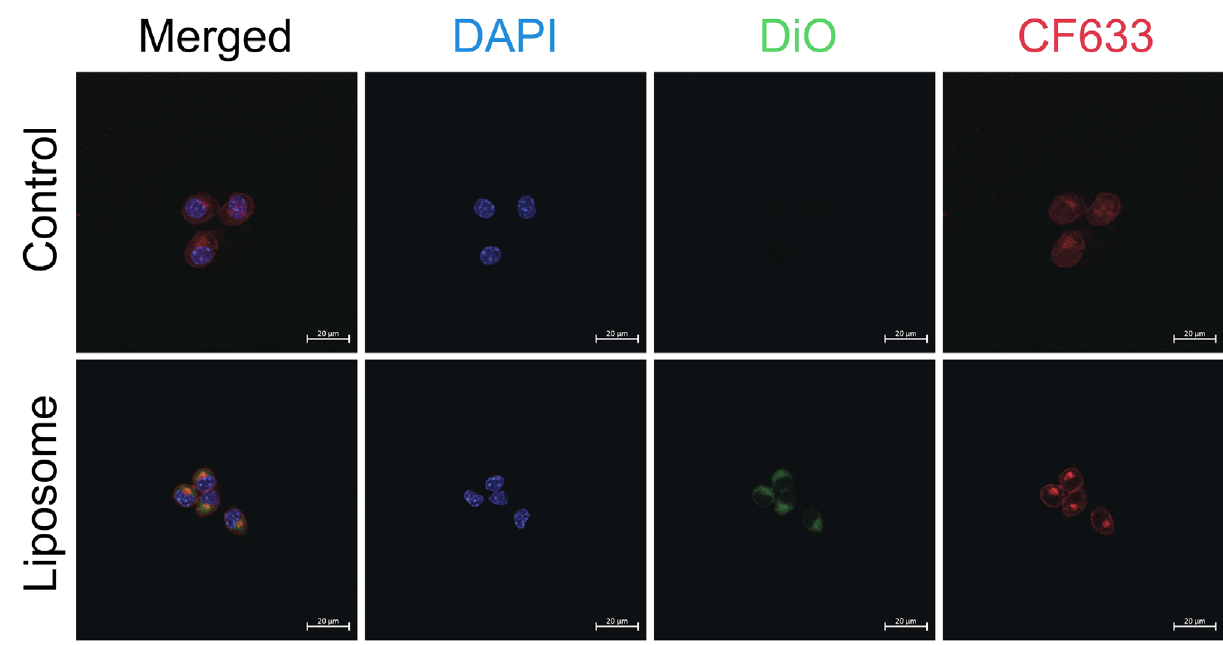
Figure 3. RAW 264.7 macrophages were incubated with DiO-liposomes (green) for 4 h before being washed, fixed, permeabilized, and stained with DAPI (blue) for nuclei visualization and phalloidin CF6333 (red) for F-actin visualization. There is a visible DiO signal inside cells that were treated with DiO-liposomes, with an expected near-background signal in the untreated controls. The scale bars indicate 20 µm.